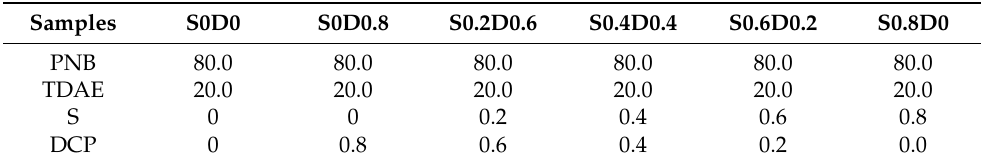
Table 1. PNB formula with different amounts of